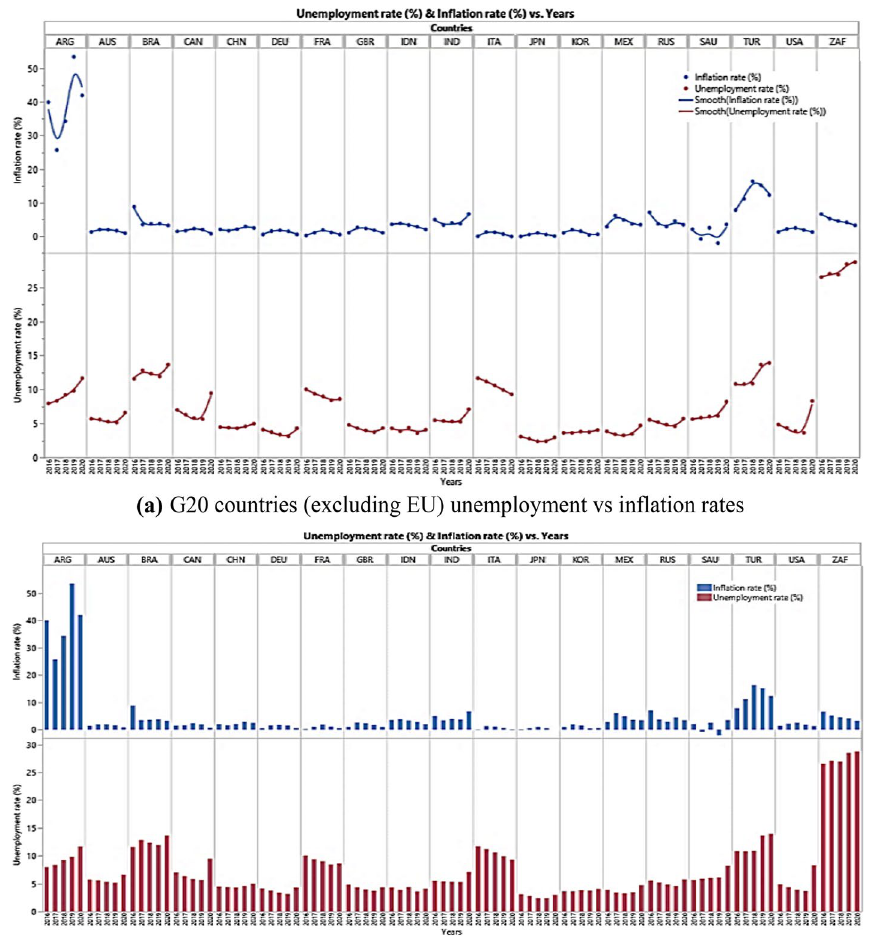
Fig. 9 a G20 countries (excluding EU) unemployment vs inflation rates. b Smoothed curvature plot for G20 countries (excluding EU) unemployment vs inflation